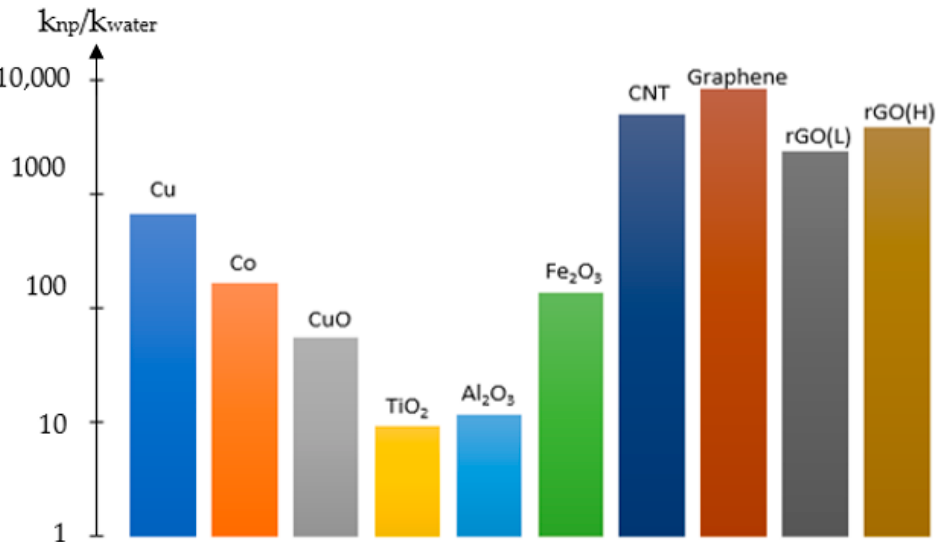
Figure 1. Thermal conductivity ratios (in log-scale) of the nanoparticle materials to thermal conduc- tivity of water at 293 K. Nanoparticle and water thermal conductivity values are taken from [11]. Abbreviations: L: lower limit, H: upper limit of the thermal conductivity value. Table 1. Parameter summary of the previous works on the GNP-water